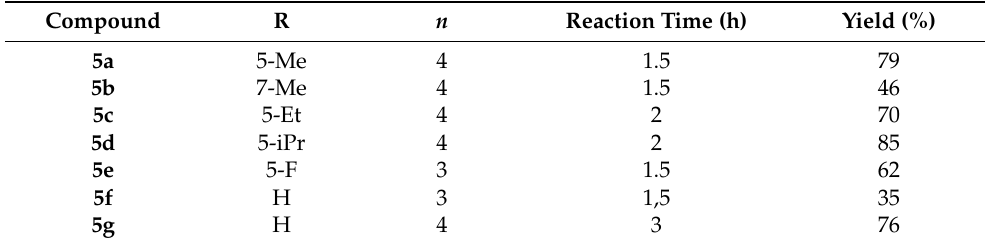
Table 1. Synthesis of ω -azidoalkyl derivatives 5a –